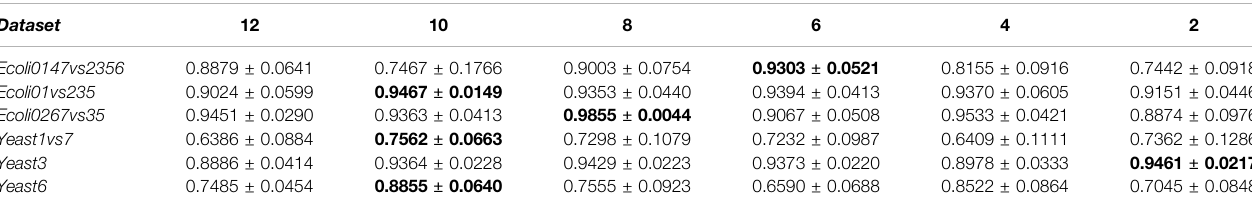
TABLE 8 | Classi fi cation results of DFSVM with different number of neurons for AUC. Dataset